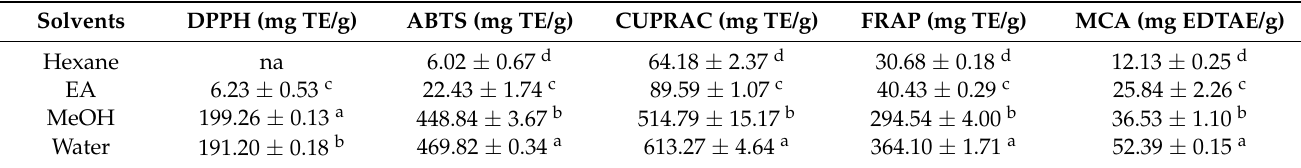
Table 3. Antioxidant properties of the tested